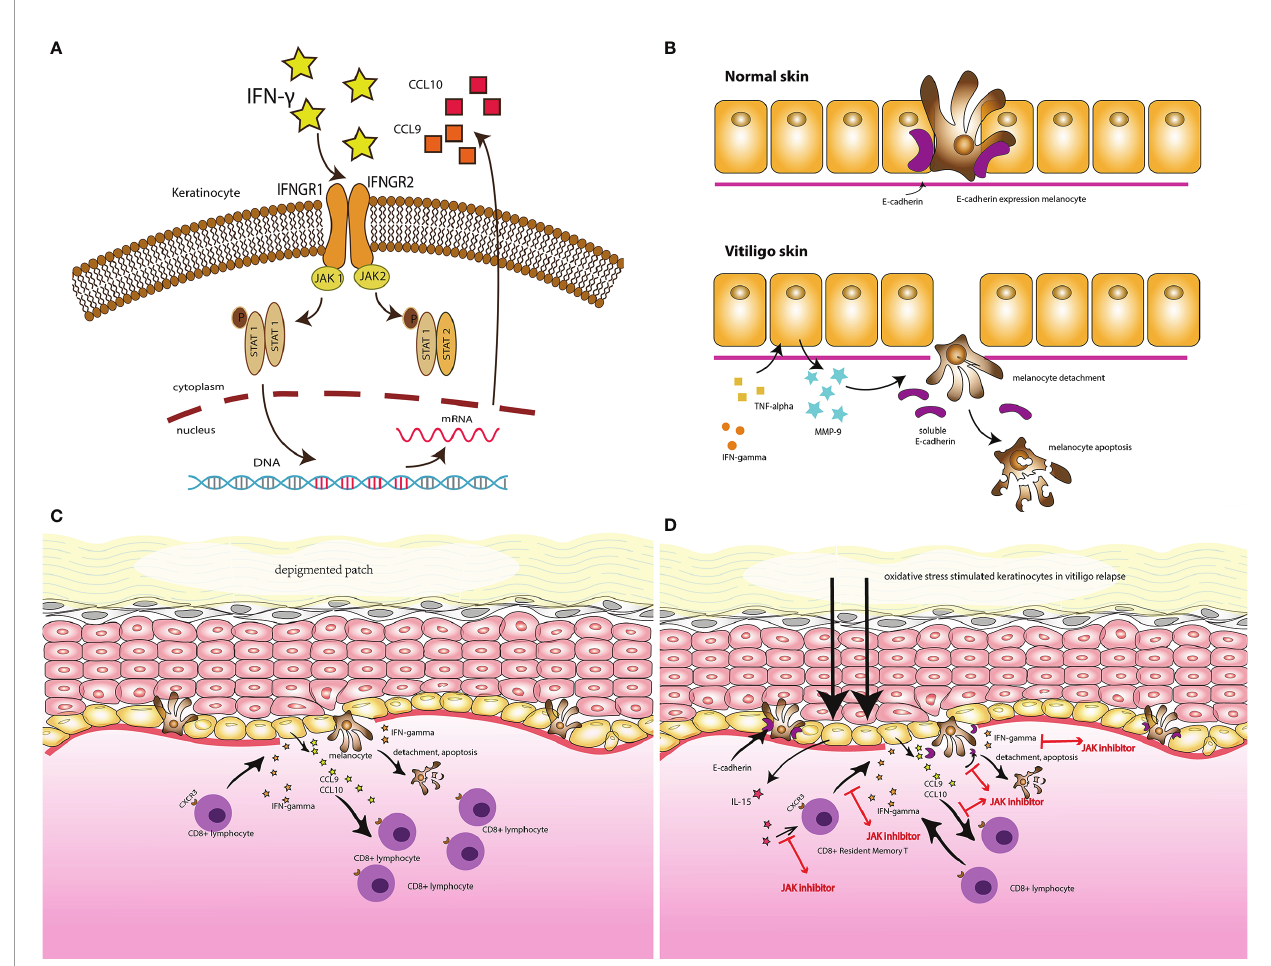
FIGURE 1 | (A) IFN- g signaling and the Janus kinase (JAK)/signal transducer and activator of transcription (STAT) pathway in vitiligo. (B) The secretion of MMP-9 by keratinocytes, in response to IFN- g and TNF- a , induced melanocytes detachment through E-cadherin disruption and released its soluble form, in the vitiligo skin comparing with the normal skin. (C) Illustrates the vitiligo pathogenesis: the IFN- g -chemokine axis, with its associated positive-feedback loop: the autoreactive CD8+ T cells produce IFN- g , which promotes depigmentation; IFN- g simultaneously stimulates keratinocytes to express CXCR3 that binds to CXCL9 to recruit more melanocyte-reactive T cells. In addition, CXCL10 recruits T cells within the skin through the CXCR3 receptor, which prolongs and exacerbates the established vitiligo lesion. (D) The potential target for JAK inhibitors to treat